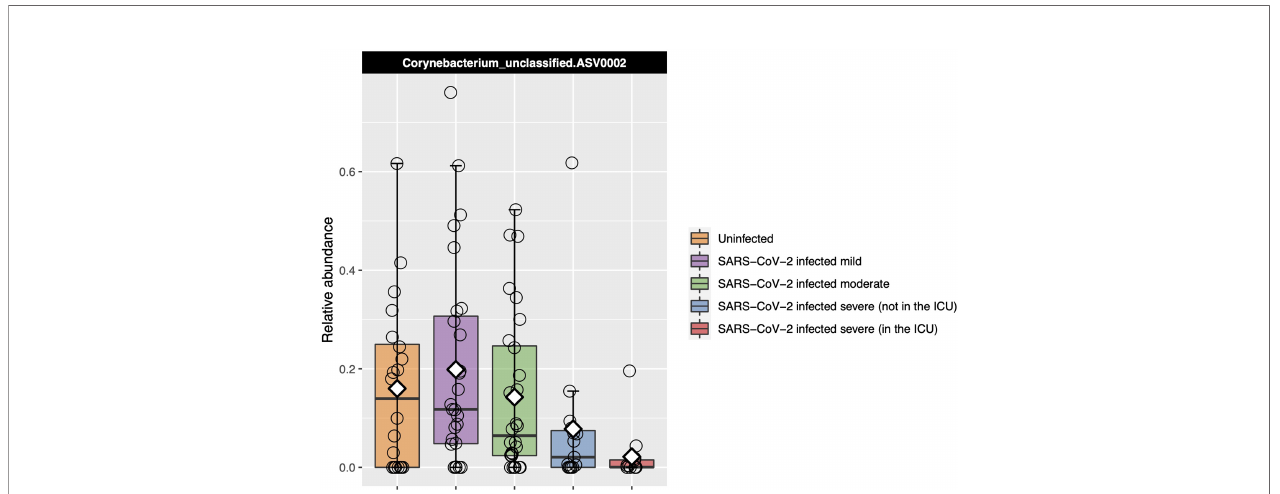
FIGURE 4 | Relative abundance of the one ASV that was identi fi ed as signi fi cantly differentially abundant by Kruskal – Wallis testing between the COVID-19 groups and that also had a median which consistently changed as COVID-19 severity increased. Each box represents the median and interquartile range, and the mean is shown by the white diamond. Individual points are shown as open circles. Corynebacterium _unclassi fi ed.ASV0002 abundance decreased as disease severity